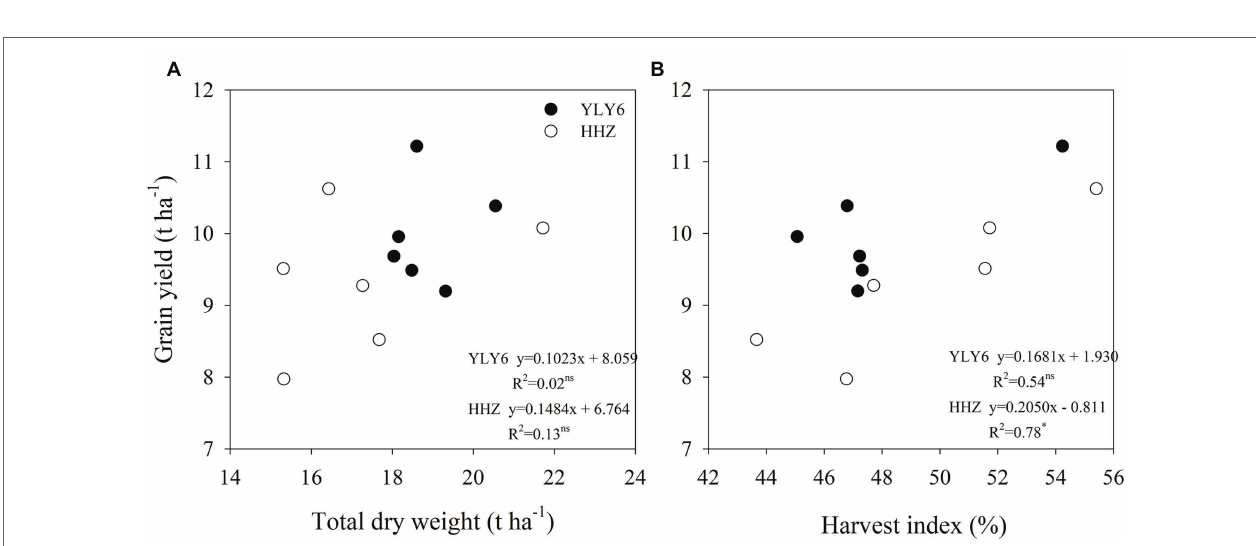
FIGURE 5 | Correlations of total dry weight (A) and harvest index (B) with grain yield for YLY6 and HHZ ( n = 6), respectively. ns and ∗ are not statistically significant and significant at the p ≤ 0.05 probability level according to the Student’s t test,